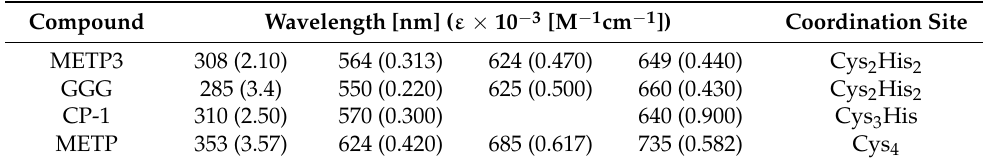
Table 1. UV-visible spectral data of Co(II) complexes of METP3.